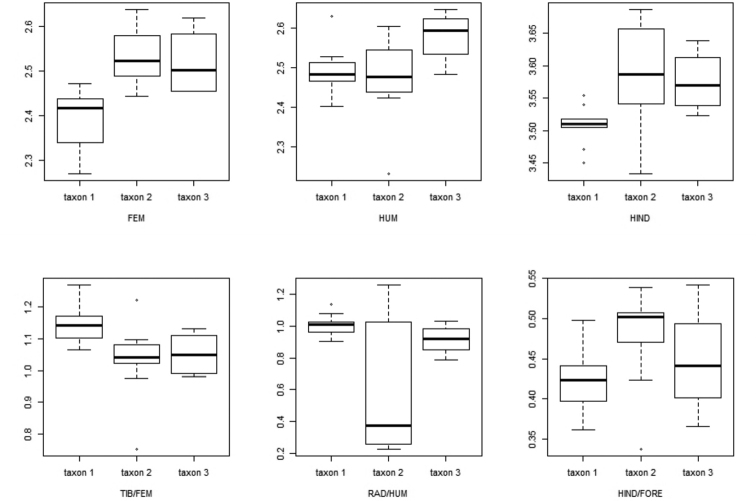
Boxplot of the most differing characters related to limb values between taxon 1, taxon 2, and taxon 3. Characters were corrected to SVL and log–transformed. For abbreviations see Materials and methods.